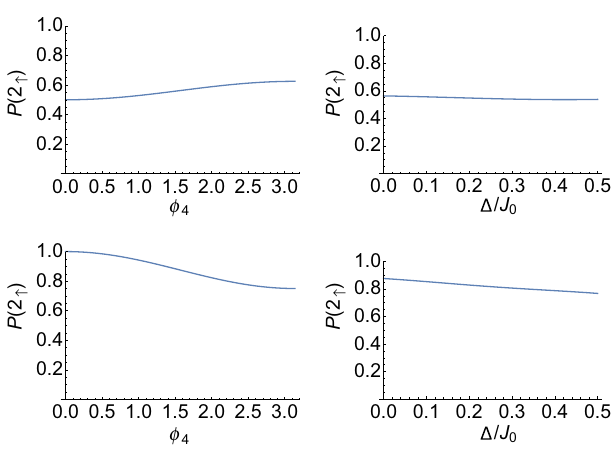
FIG. 5. The probability that dot 2 will be measured in spin state ↑ after a sequence of gates is applied to the initial state |↑ + ↓ + ↑ + ↓ + (cid:3) , with φ 1 = φ 2 = φ 3 = 0. Top left: the gate sequence is given by Eq. (14) and (cid:2) = 0. Top right: the gate sequence is given by Eq. (14) and φ 4 = π/ 2. Bottom left: the gate sequence is given by Eq. (17) and (cid:2) = 0. Bottom right: the gate sequence is given by Eq. (17) and φ 4 = π/